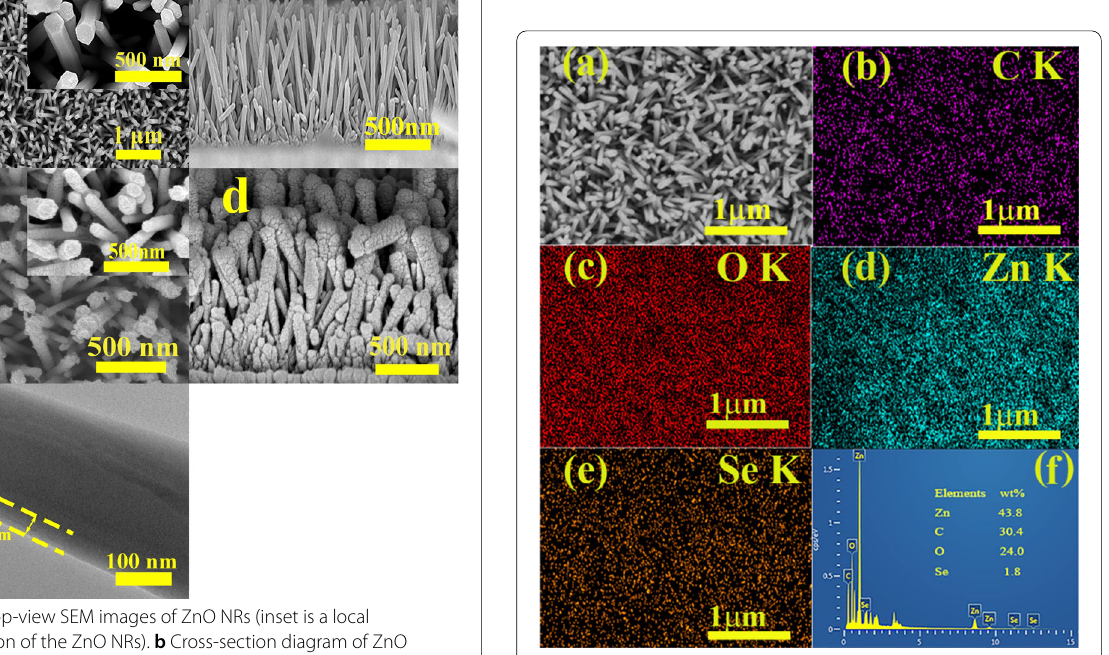
Fig. 2 a The top view SEM imageof ZnO NRs/PEDOS. b – e The element mapping images of ZnO NRs/PEDOS: b element C,